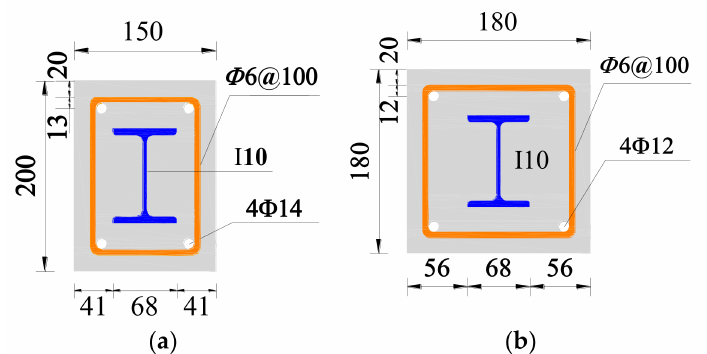
Figure 1. The section of steel reinforced recycled aggregate concrete (SRRAC) beam and column. ( a ) Beam section; ( b ) Column section.